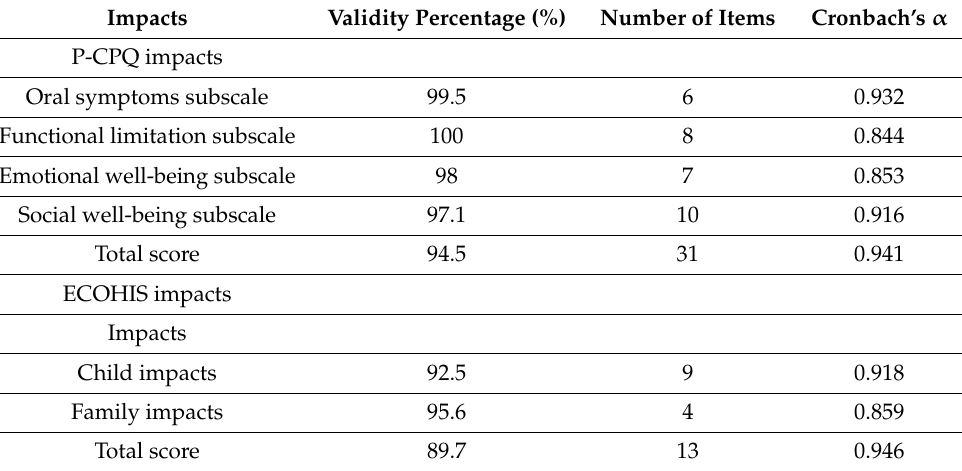
Table 7. Cronbach’s alpha